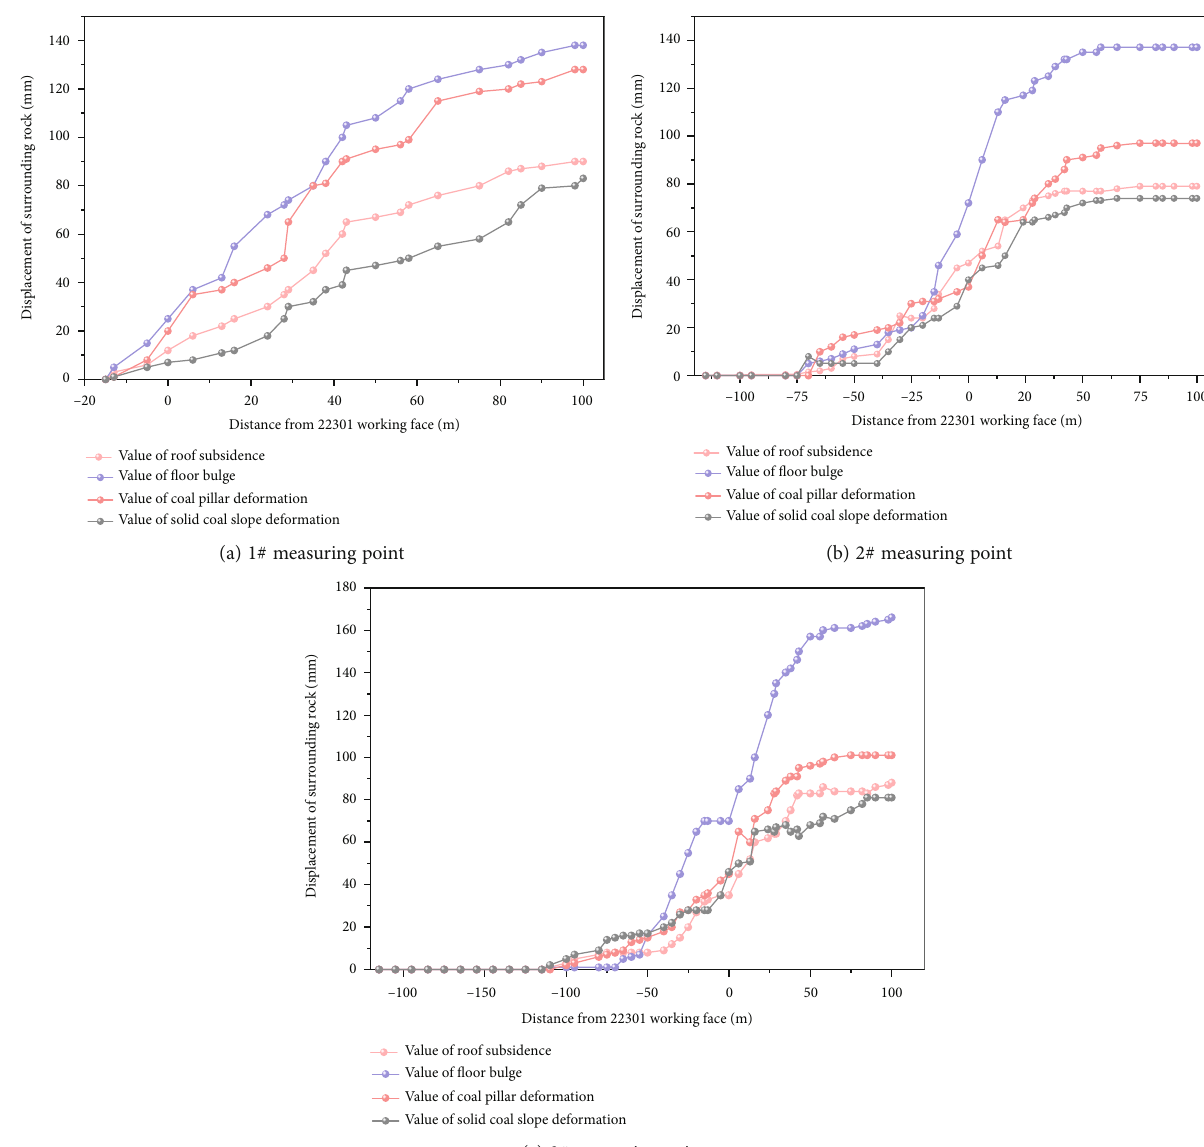
(c) 3# measuring point Figure 12: Deformation of roadway surrounding